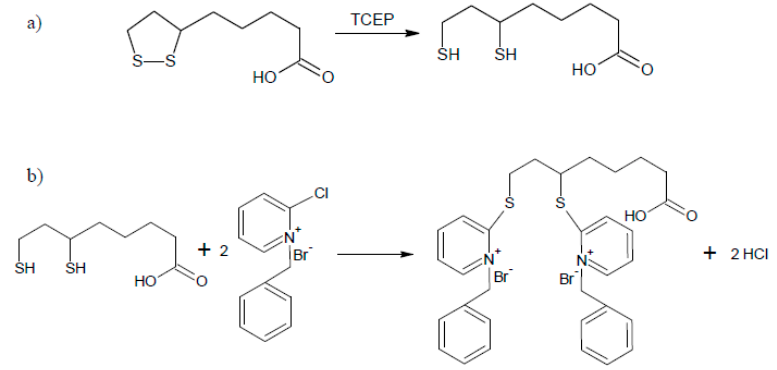
Figure 6. Schemes of chemical reduction reaction equation of α -lipoic acid with tris -(2-carboxyethyl)phosphine ( a ) and chemical derivatization reaction equation of dihydrolipoic acid with 1-benzyl-2-chloropyridinium bromide ( b ).